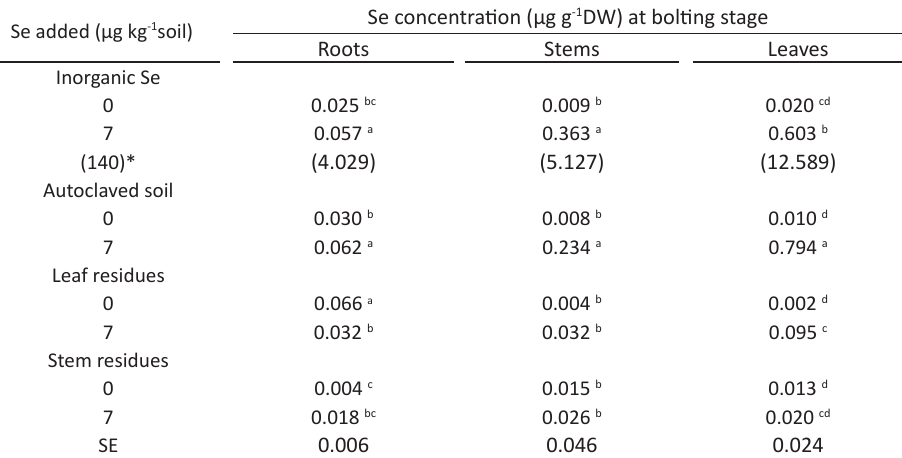
Table 4. Se concentrations (µg g -1 DM) in roots, stems and leaves of B. napus L. plants grown in soils treated with inorganic Se (0, 7 and 140 µg kg -1 soil), organic Se (leaf and stem residues, 0 and 7 µg kg -1 soil) and in autoclaved soils with inorganic Se (0 and 7 µg kg -1 soil) at the bolting stage Se added (µg kg -1 soil)